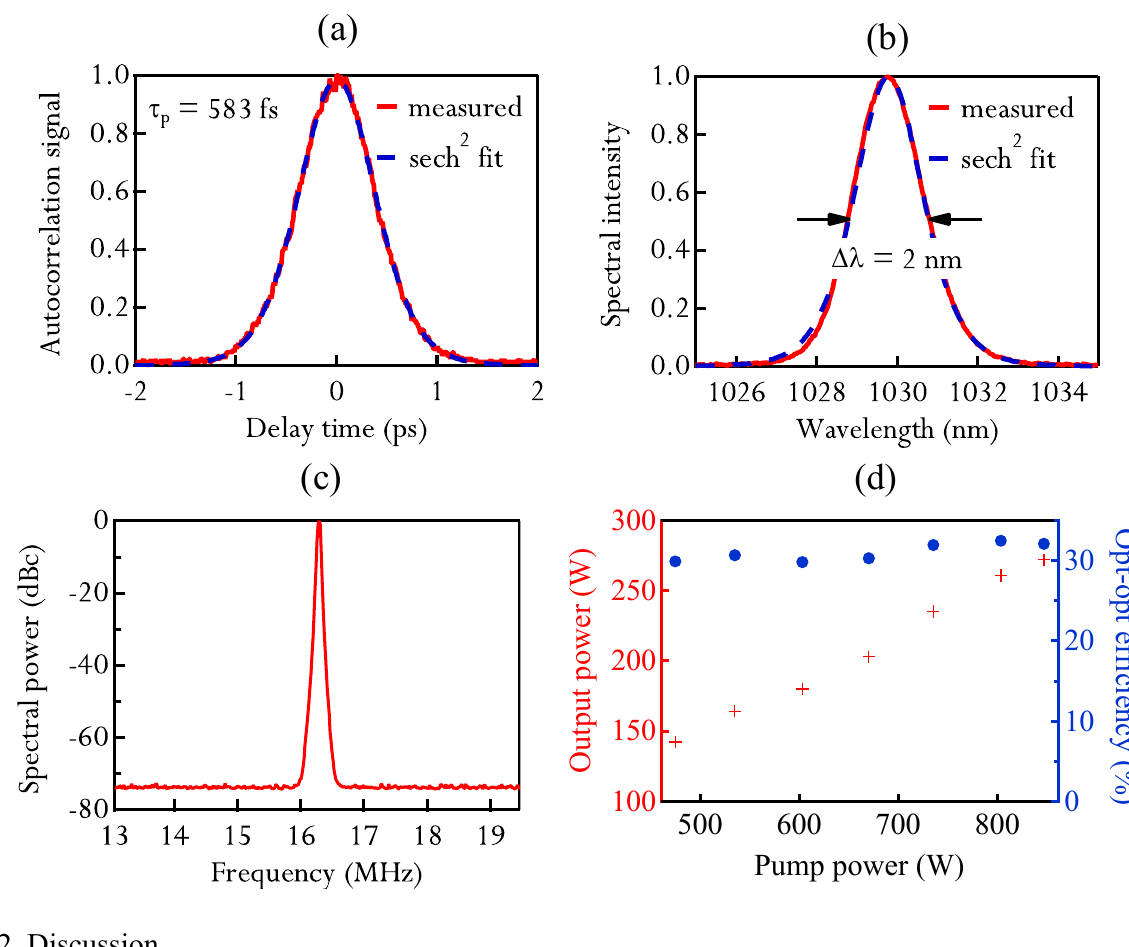
Figure 5. ( a ) Autocorrelation trace of the pulses at the maximum average output power of 275 W; ( b ) Optical spectrum of the pulses; ( c ) Radio frequency spectrum of the pulses, with a resolution bandwidth of 30 kHz; ( d ) Output power and optical-to-optical efficiency in modelocked operation as a function of pump power. The points before modelocking were not measured in order to avoid damage of intracavity components during the Q-switched modelocking (QML) regime that occurs before modelocked